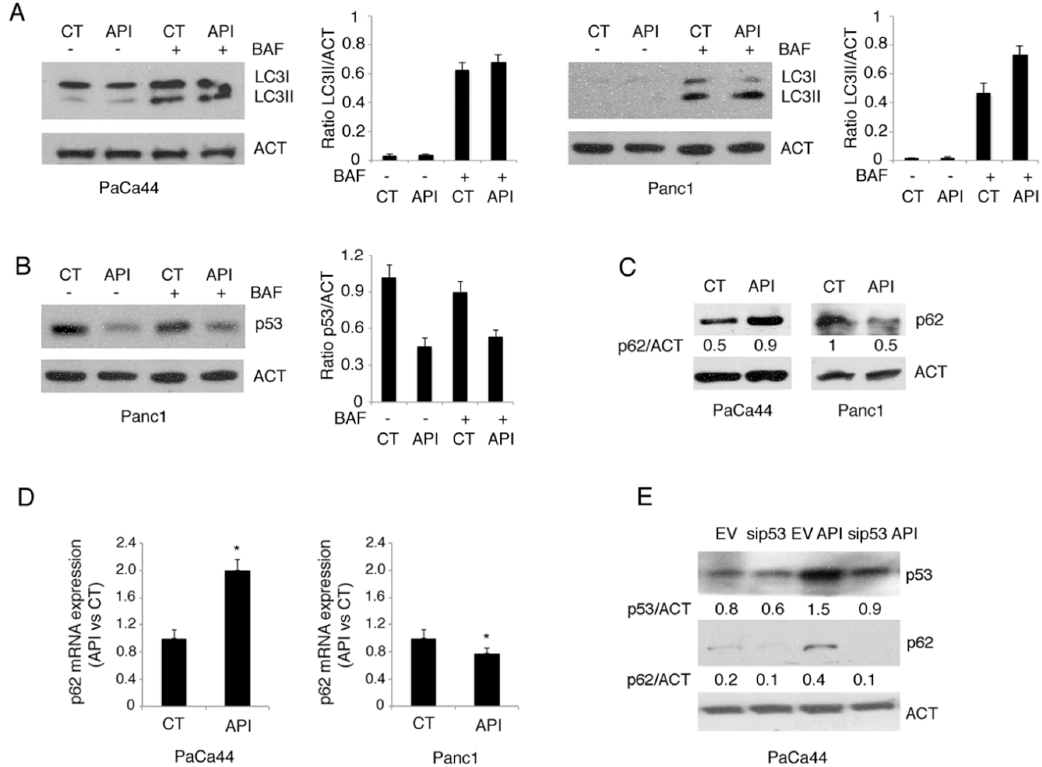
Figure 4. Apigenin-mediated induction of p62 is mutp53 dependent in PaCa44 cells. ( A ) LC3II expression in Apigenin-treated or untreated PaCa44 and Panc1 cells in the presence or not of 20 nM Bafilomycin (added the last 2 h) was evaluated by western blot analysis. Actin was used as loading control. A representative experiment out of three is shown and the densitometric analysis of the ratio of LC3 / actin is reported; ( B ) mutp53 expression in Apigenin-treated or untreated Panc1 cells in the presence or not of 20 nM Bafilomycin (added the last 2 h) was evaluated by western blot analysis. Actin was used as loading control. A representative experiment out of three is shown and the densitometric analysis of the ratio of p53 / actin is reported; ( C ) p62 expression in Apigenin-treated or untreated PaCa44 and Panc1 cells evaluated by western blot analysis. Actin was used as loading control. A representative experiment out of three is shown and the densitometric analysis of the ratio of p62 / actin is reported; ( D ) p62 RNA was evaluated by qRT-PCR in Apigenin-treated or untreated PaCa44 and Panc1 cells. Target mRNA level was normalized to actin gene. Data are plotted in histograms showing standard deviation (SD). * p -value < 0.05. ( E ) mutp53 and p62 expression in p53-or scramble-silenced PaCa44 cells treated or untreated with Apigenin was evaluated by western blot analysis. Actin was used as loading control. A representative experiment out of three is shown and the densitometric analysis of the ratio of p53 / actin and p62 / actin is reported. Control (CT); Apigenin (API); bafilomycin (BAF); microtubule-associated protein light chain 3 (LC3I); lipidated microtubule-associated protein light chain 3 (LC3II); actin (ACT); empty vector (EV); p53 siRNA